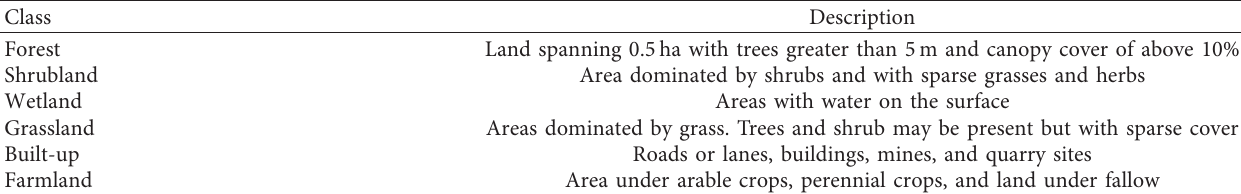
Table 1: FAO classification scheme